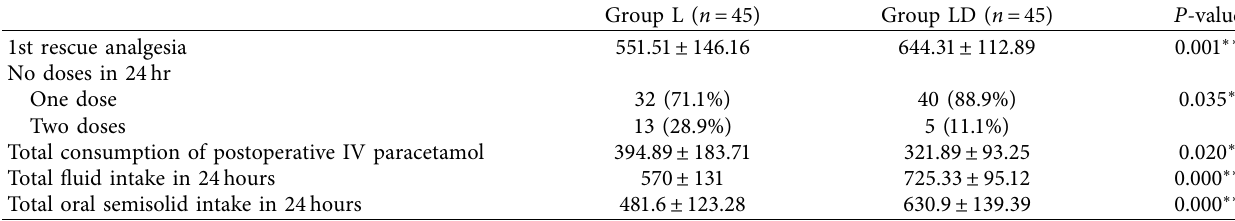
Table 2: Time to first request, total consumption of postoperative IV paracetamol rescue analgesia, total fluid, and semifluid intake.